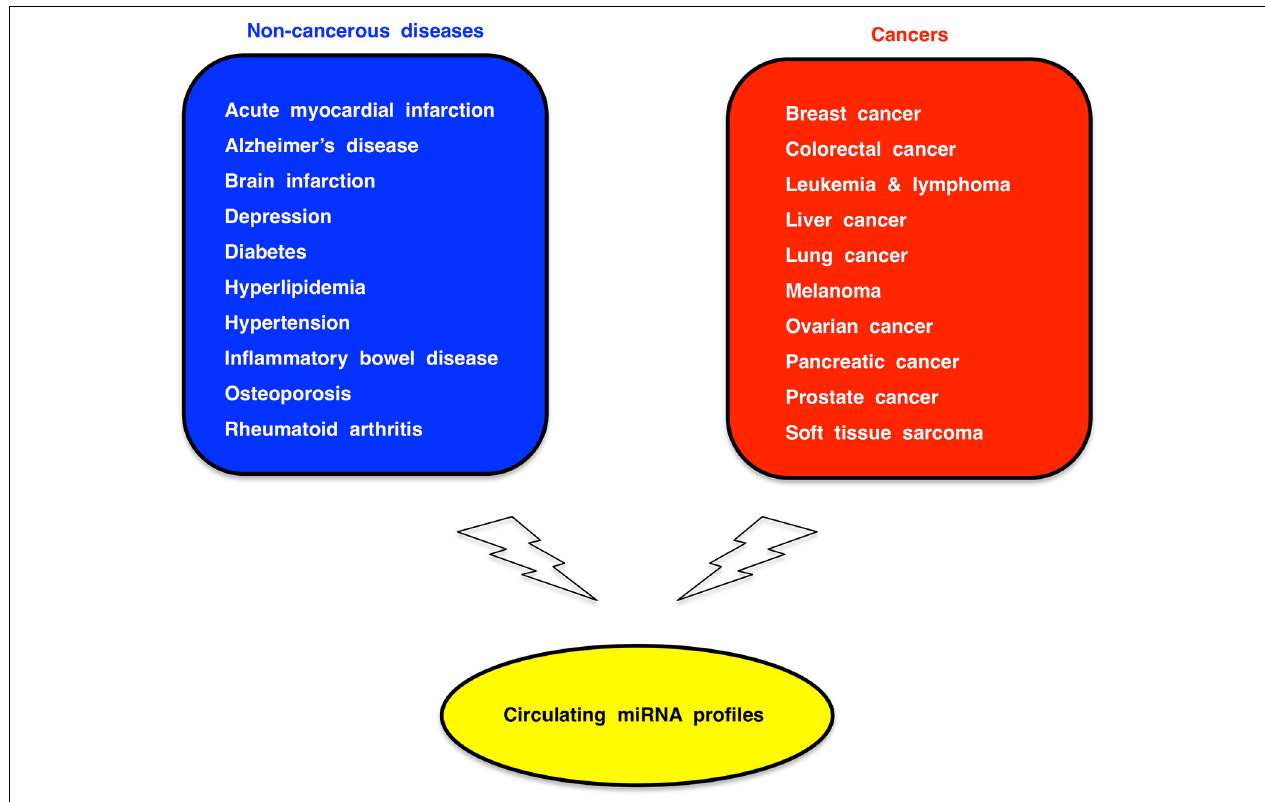
FIGURE 6 | Circulating miRNA association study (CMAS). Dysregulation of circulating miRNAs occur in a variety of human disease. Circulating miRNA profiles in several thousands of cases each